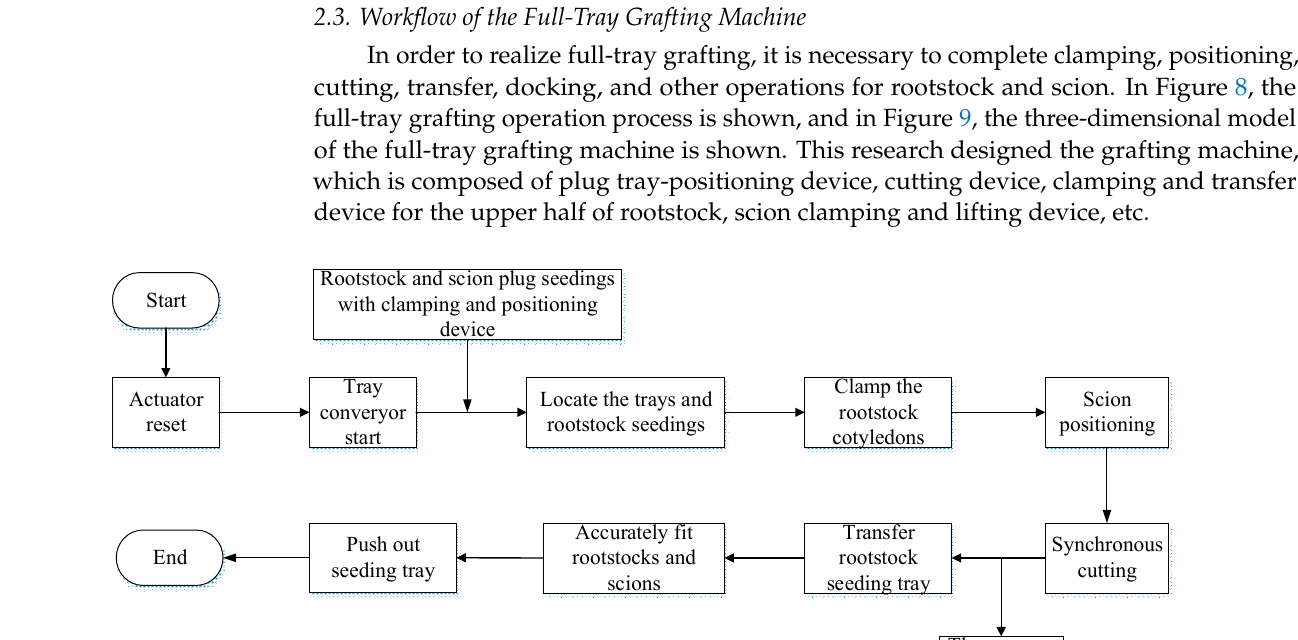
Figure 7. Details of rootstock and scion grafting.